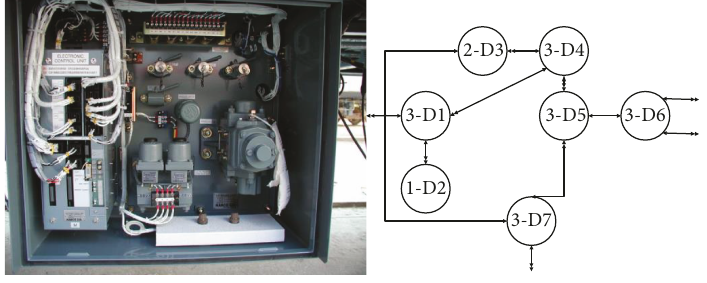
Figure 8: Model of a brake control device.